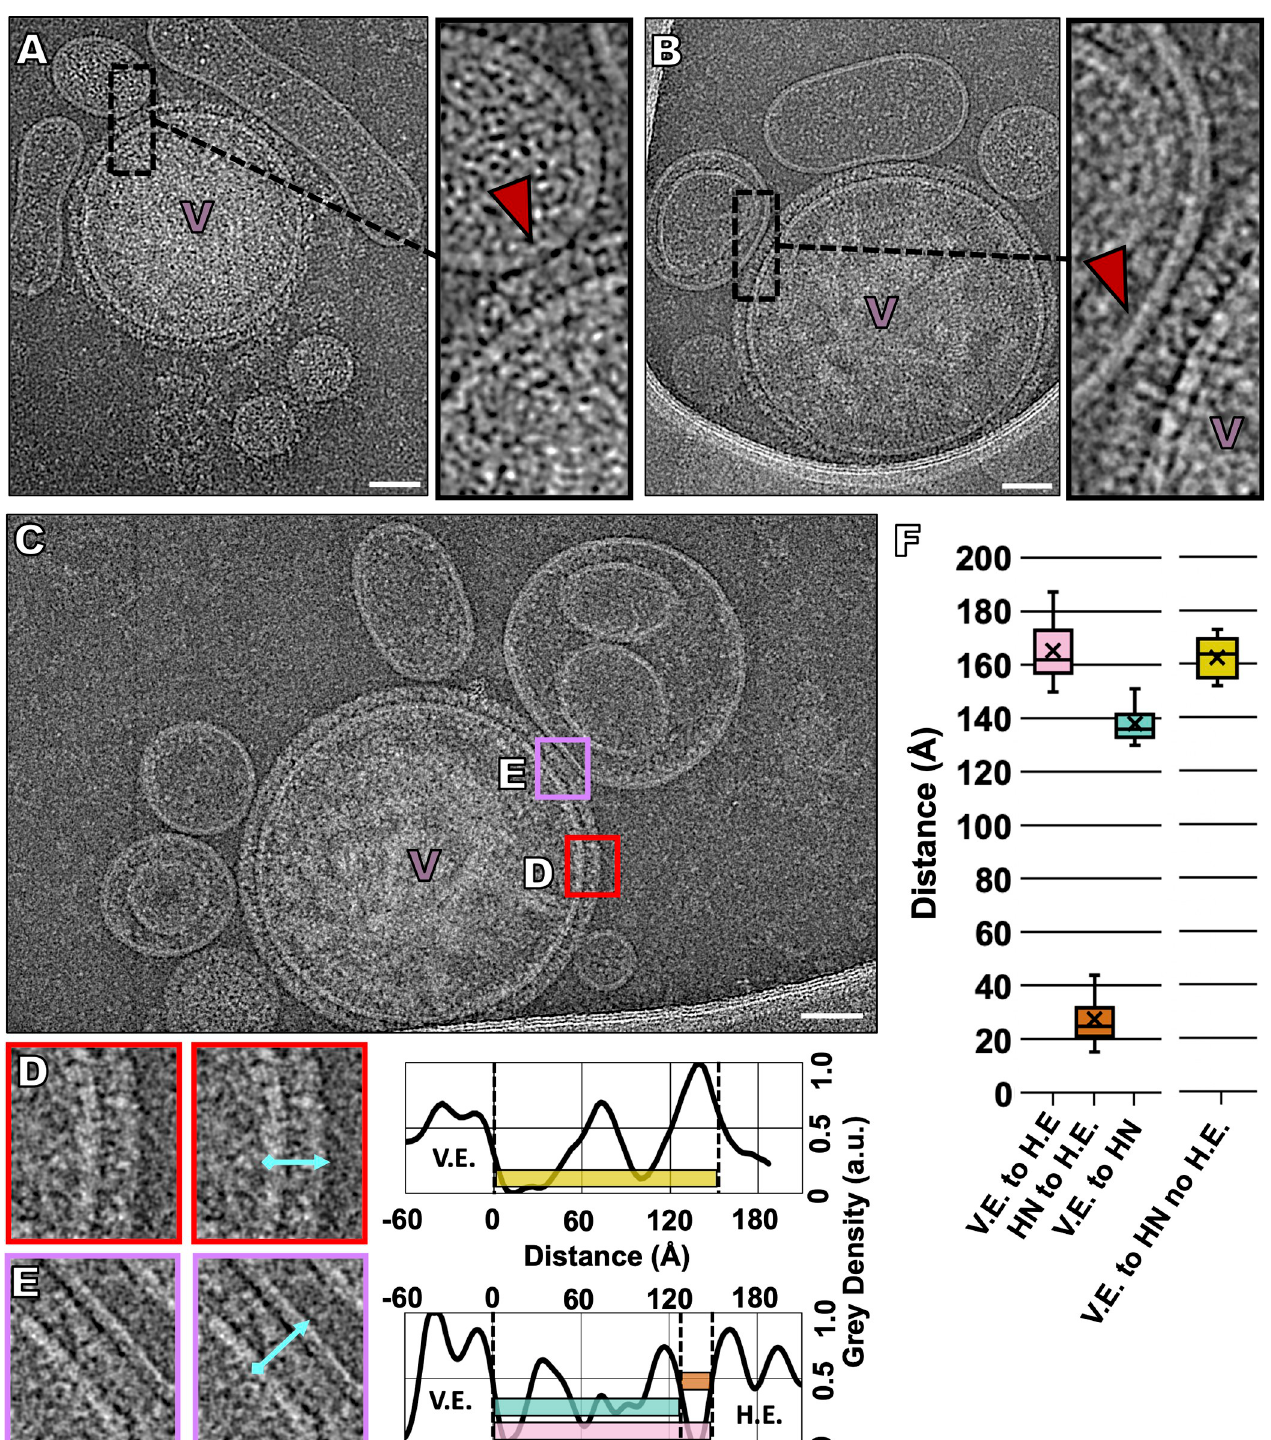
Fig 3. Imaging the interaction of the HPIV3 virions with a natural host receptor. To capture viral-host interactions and prevent the activation of F, samples were incubated at 4˚C prior to vitrification. ( A, B, C ) Contrast-inverted ( A ) cryo-ET and ( B, C ) cryo-EM images of HPIV3 interactions with target erythrocyte fragment membranes. Insets: enlarged areas show thin lines of density connecting HN to the target erythrocyte fragment membranes. ( D, E ) Enlarged regions ( D ) distal and ( E ) proximal to the viral-host interaction site with accompanying density line plots of each region. Relative density measurements in arbitrary units (a.u.) of the space between the viral envelope (V.E.) and HN or the target human erythrocyte fragment membrane (H.E.) with distances measured from